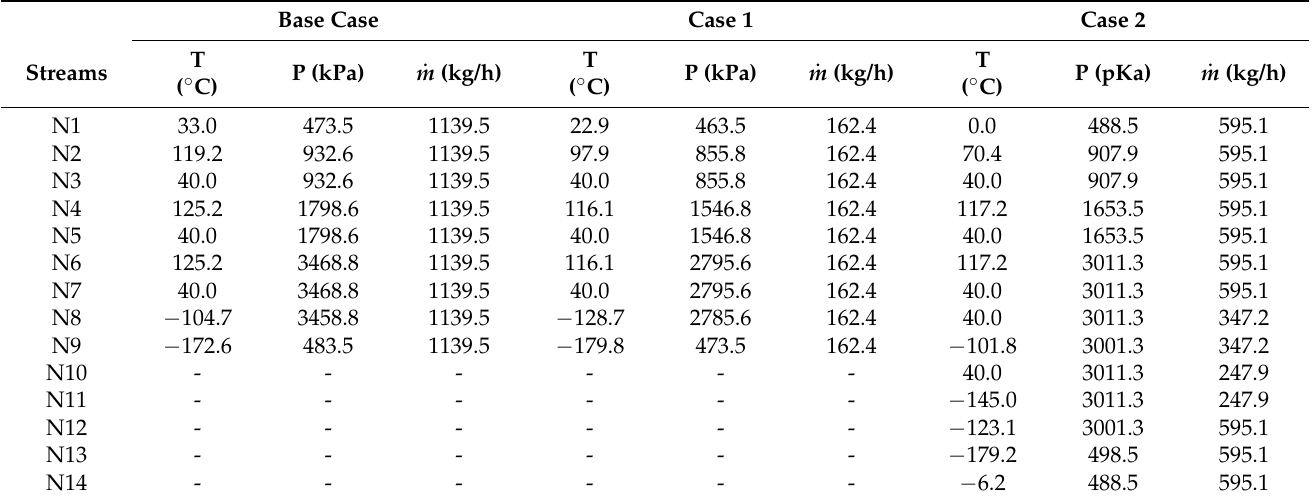
Table 6. Thermodynamic parameters of N 2 streams in the optimized systems.